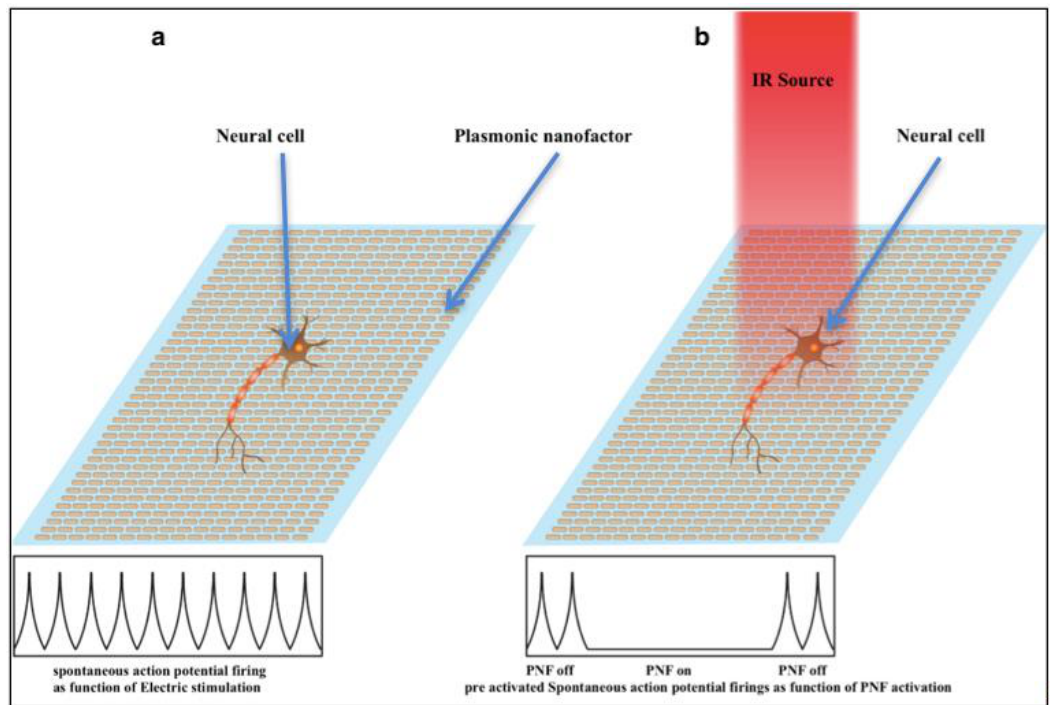
Figure 12. The general procedure for neural activity inhibition by PNF. ( a ) Preactivated neural cell by electric stimulation; ( b ) neural cell behavior under the influence of turning on and off PNF.